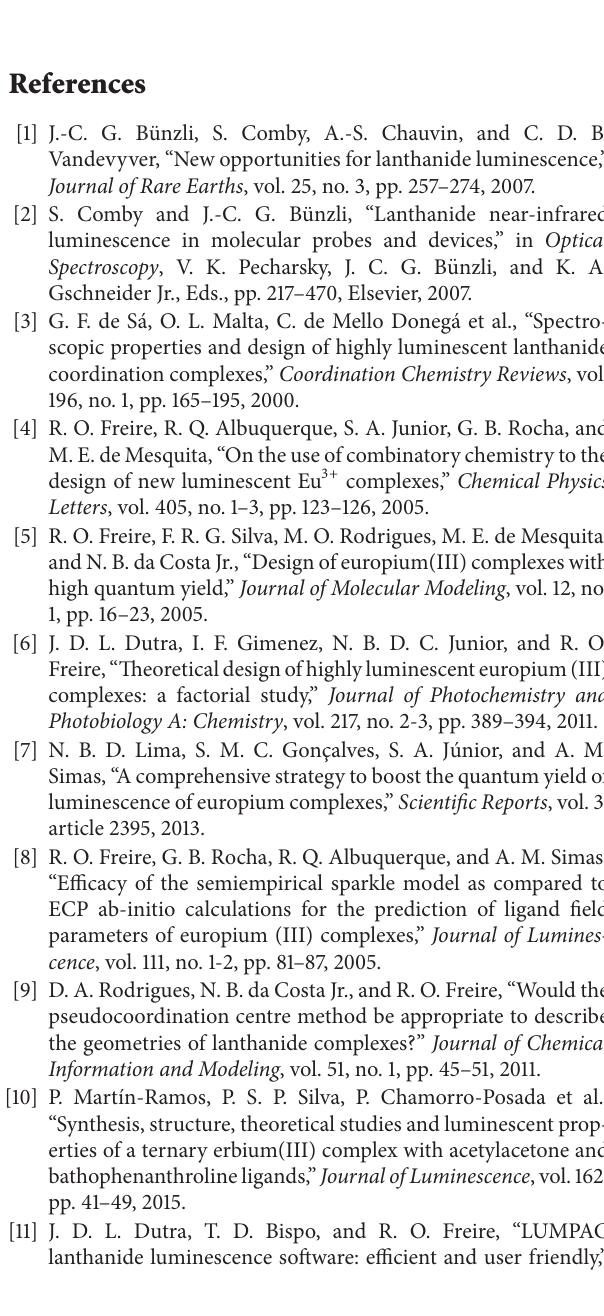
Figure 8: LUMO level for complex 1 (a) and for complex 2 (b and